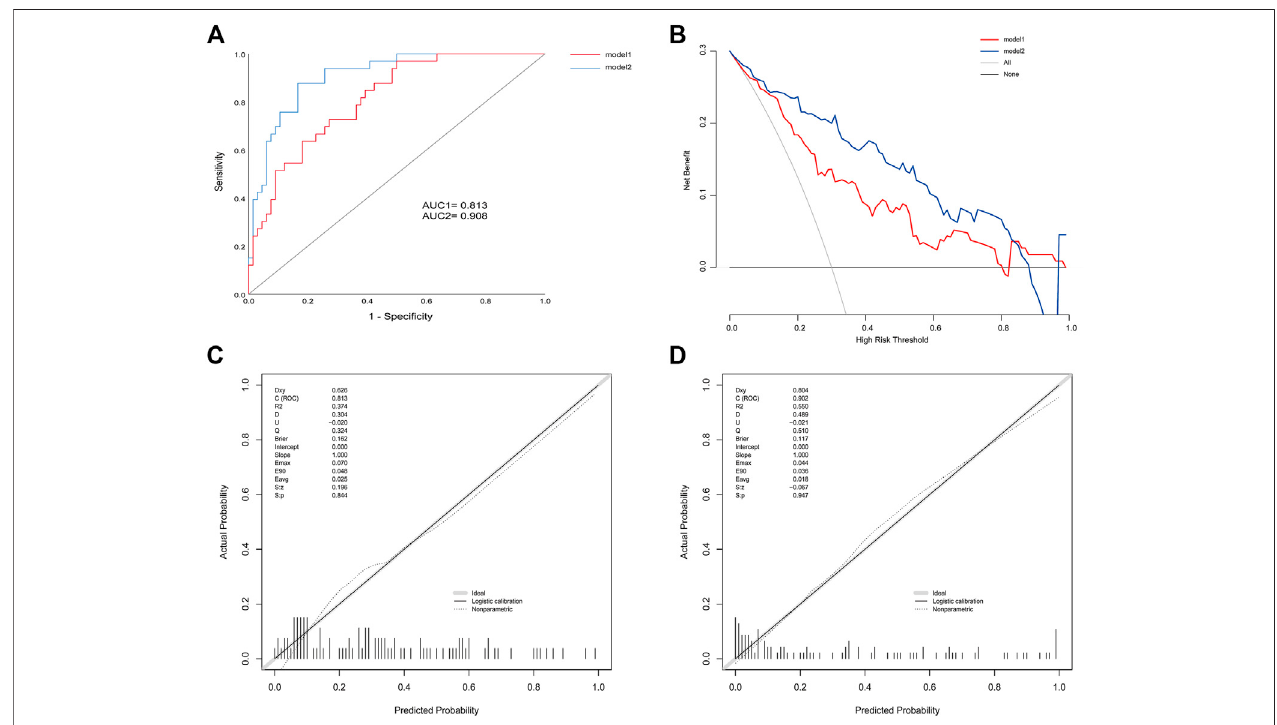
FIGURE 3 | (A) ROC for model 1 and model 2 in the validation cohort (B) Calibration plots for model 1 (C) Calibration plots for model 2 (D) DCA for model 1 and model 2 in the validation